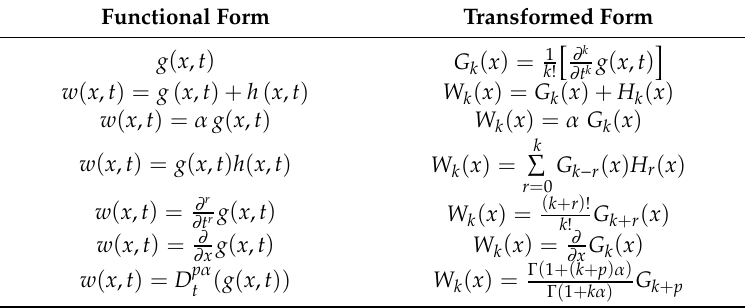
Table 1. The major operation of fractional reduced di ff erential transform method (FRDTM) [22]. Functional Form Transformed